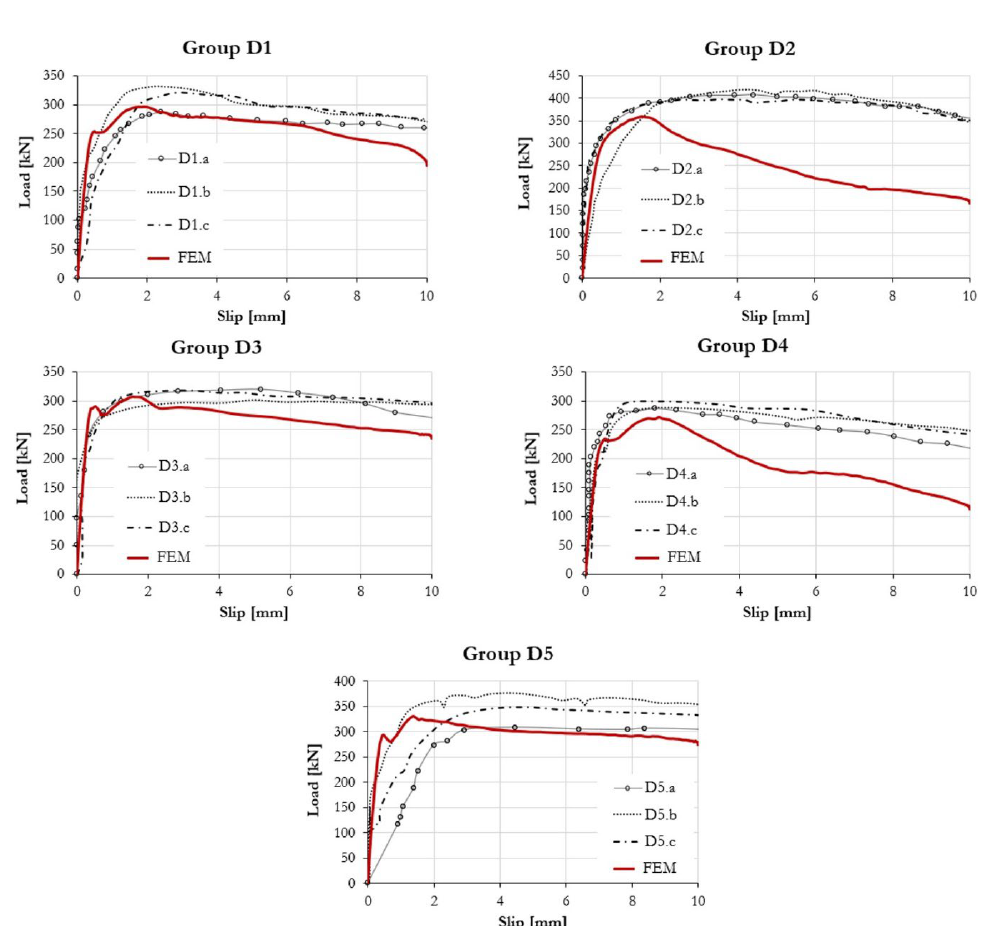
Figure 13. Comparison between experimental and numerical “load-slip”